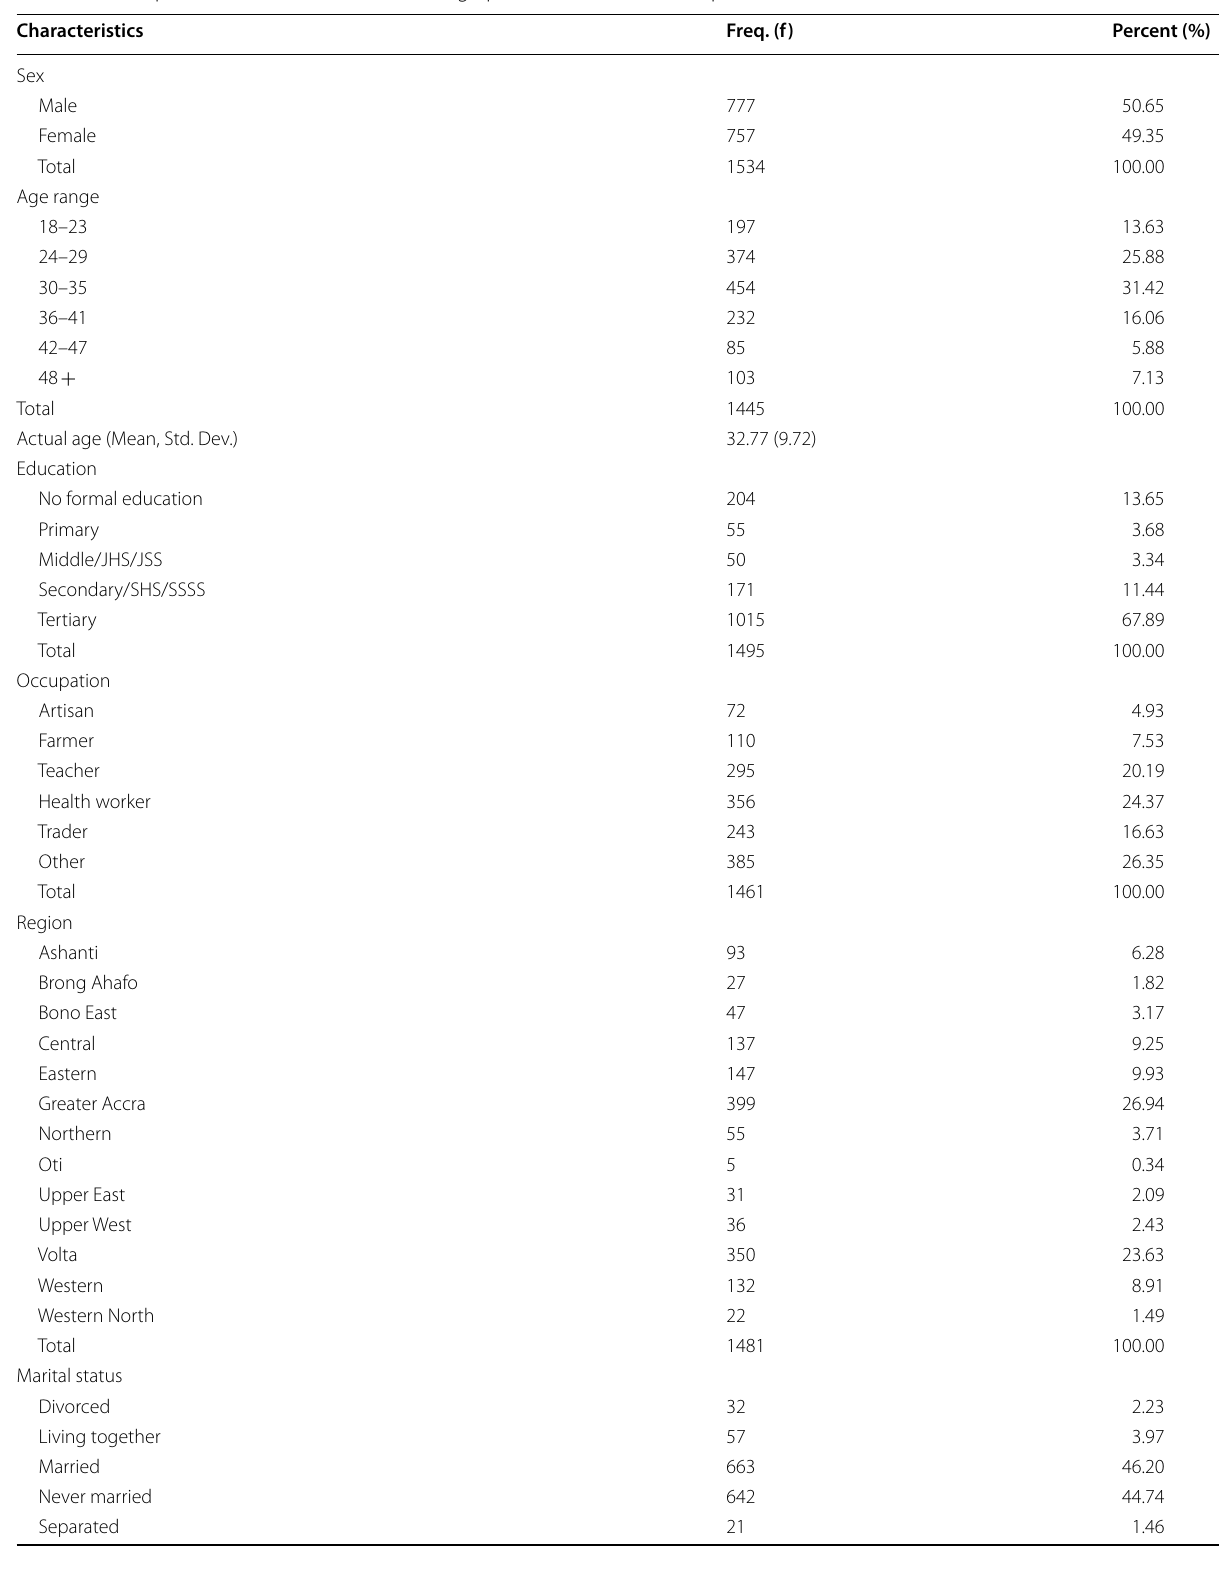
Table 1 Descriptive statistics on the socio‑demographic characteristics of respondents